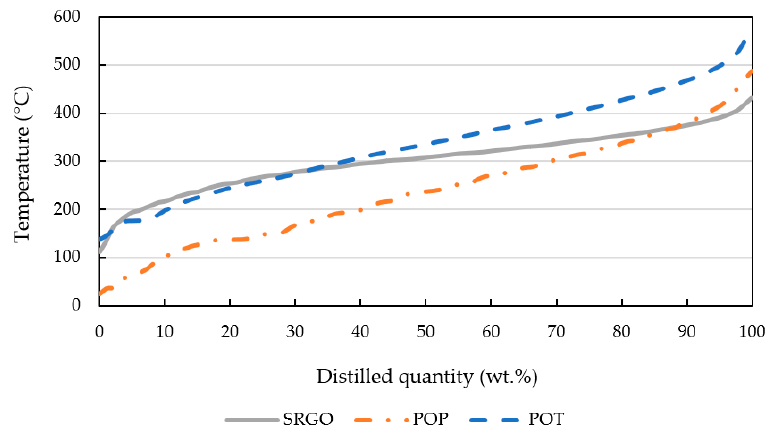
Figure 1. Distillation curves of the used